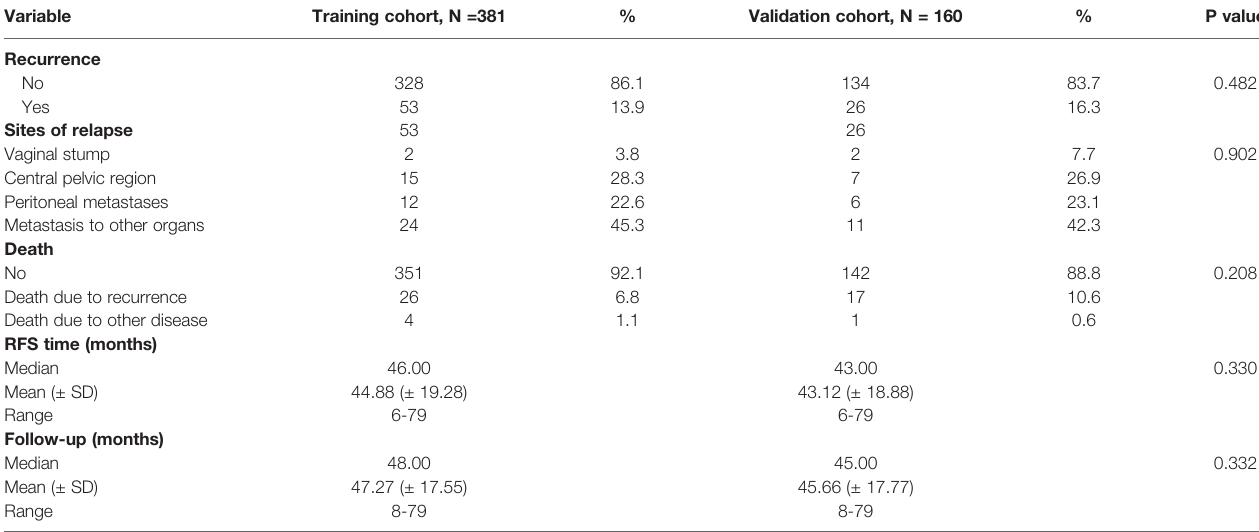
TABLE 5 | Recurrence characteristics and follow-up of patients with a follow-up time of more than 2